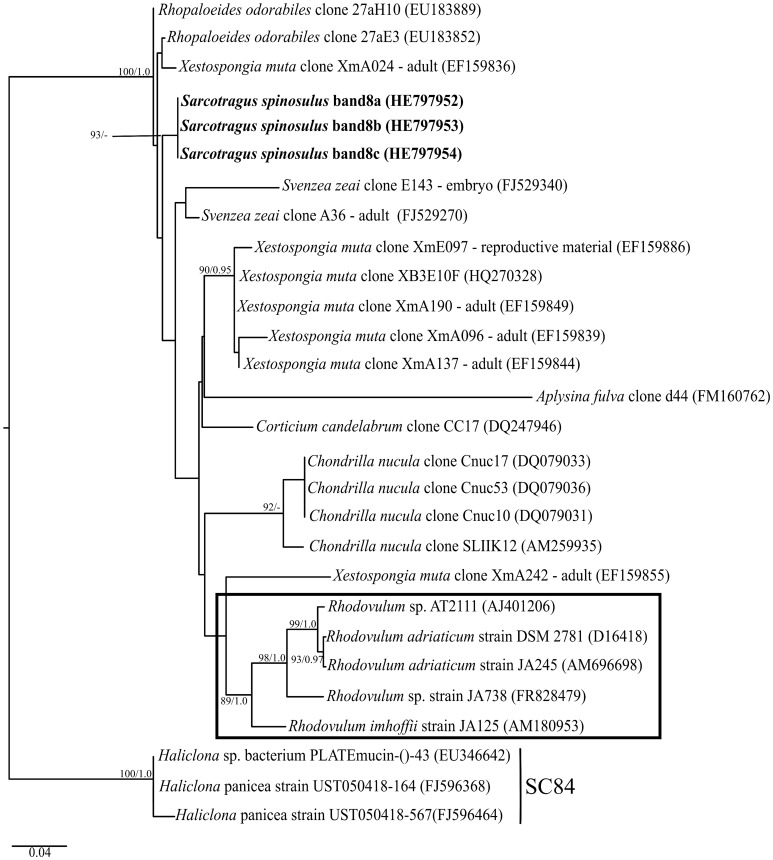
Phylogenetic inference of Alphaproteobacteria 16S rRNA genes.Tree construction procedure was as described for Figure 4, except that sequences close related to band 8 were selected along with sequences from SC84 [34], which were used as outgroup. The sequences shown in a box were isolated from different environments. The Maximum Likelihood tree is shown (-ln likelihood: 3253,686594).